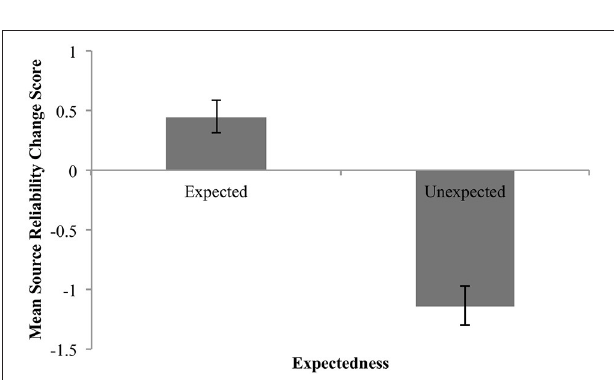
FIGURE 4 | Mean change in perceived reliability for expected and unexpected claims. Error bars are standard